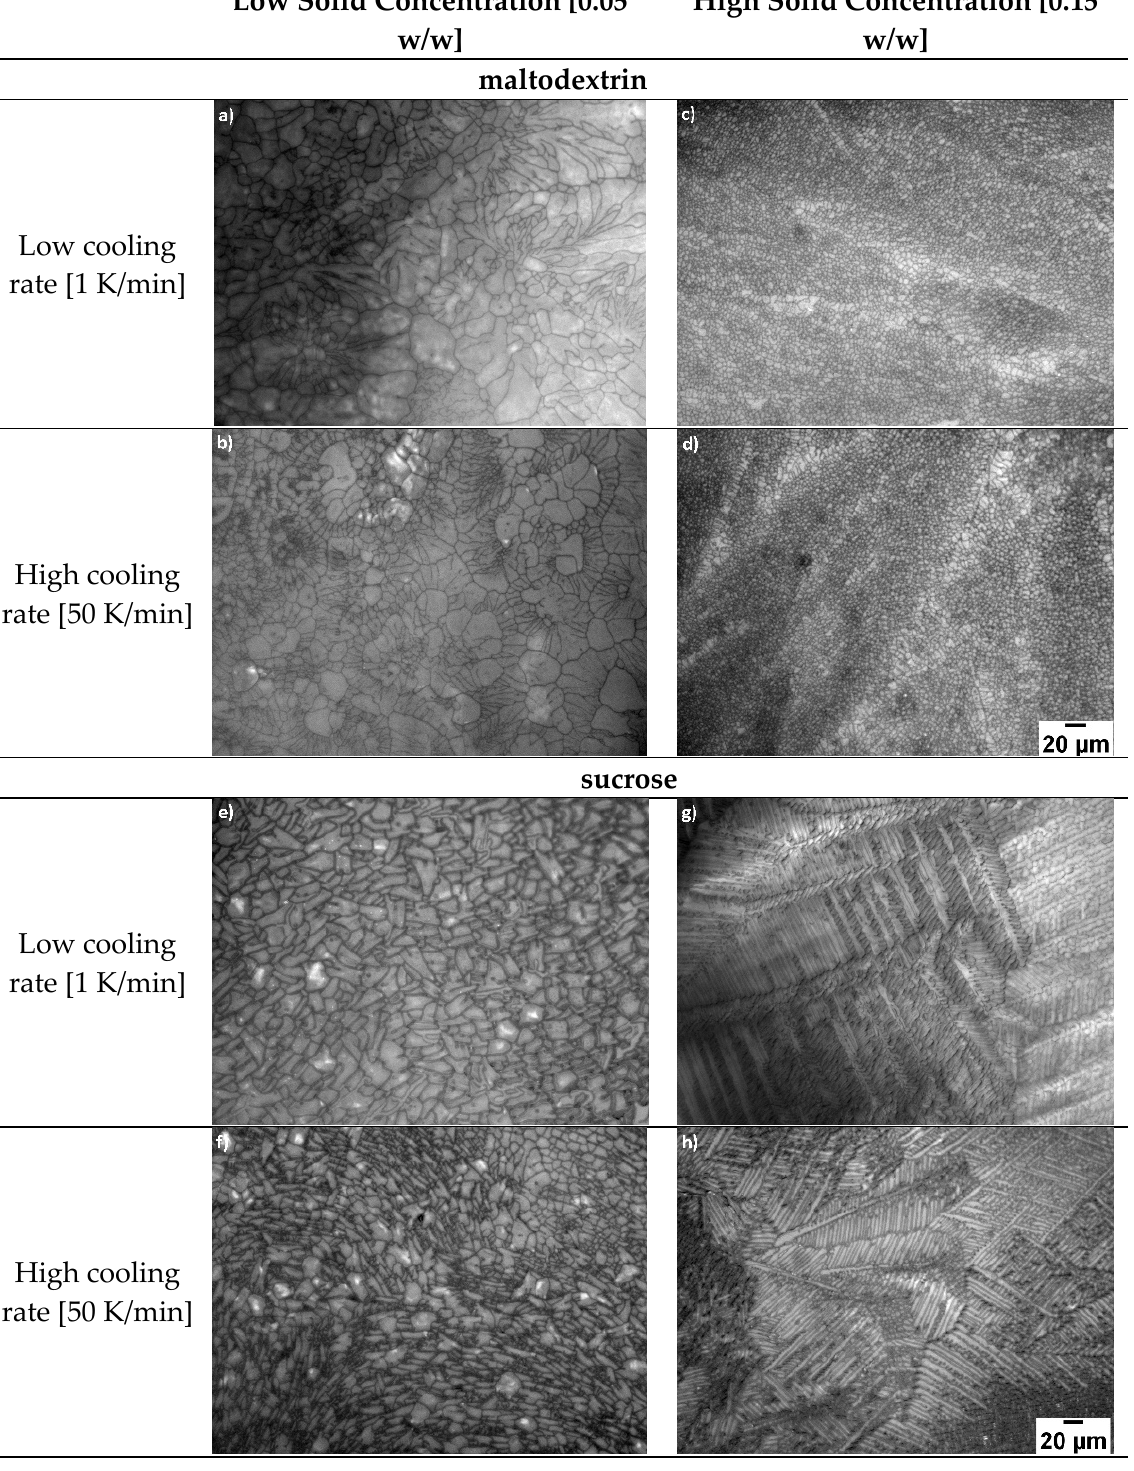
Figure 4. FDM images of microstructures obtained with different freezing parameters: (a)–(d): maltodextrin solution and (e)–(h): sucrose solution; (a),(c),(e),(g) use of low (1 K/Min) cooling rate; (b),(d),(f),(h): high (50 K/min) cooling rate; (a)–(b) and (e)–(f): low solid content (c = 0.05 w/w); (c)–(d) and (g)–(h): high solid content (c = 0.15 w/w). Scale Bar shown in (d) and (h) applies for all images.